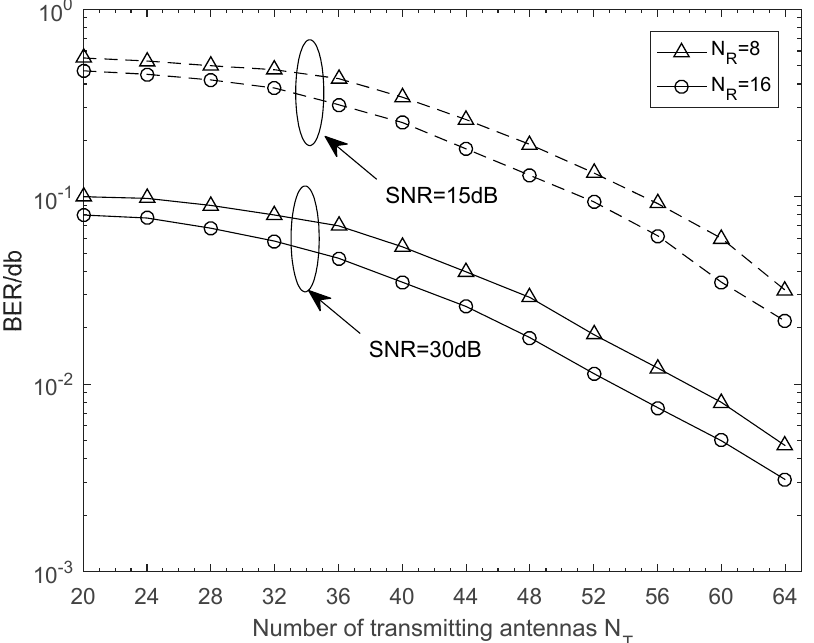
Figure 7. BER performance against the number of the transmitting antennas N T . The number of vehicles is 1, and its speed is v = 120 km/h.